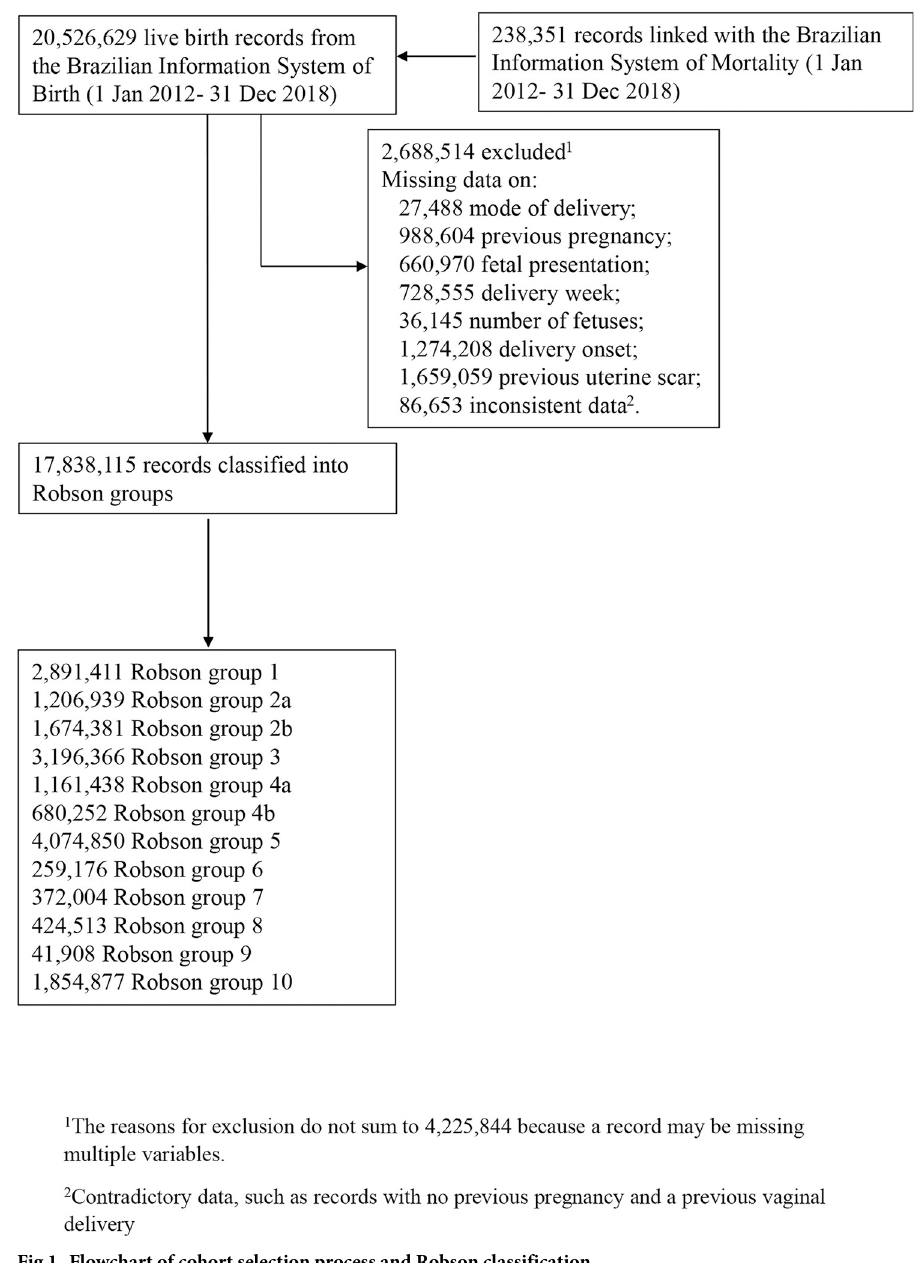
Fig 1. Flowchart of cohort selection process and Robson